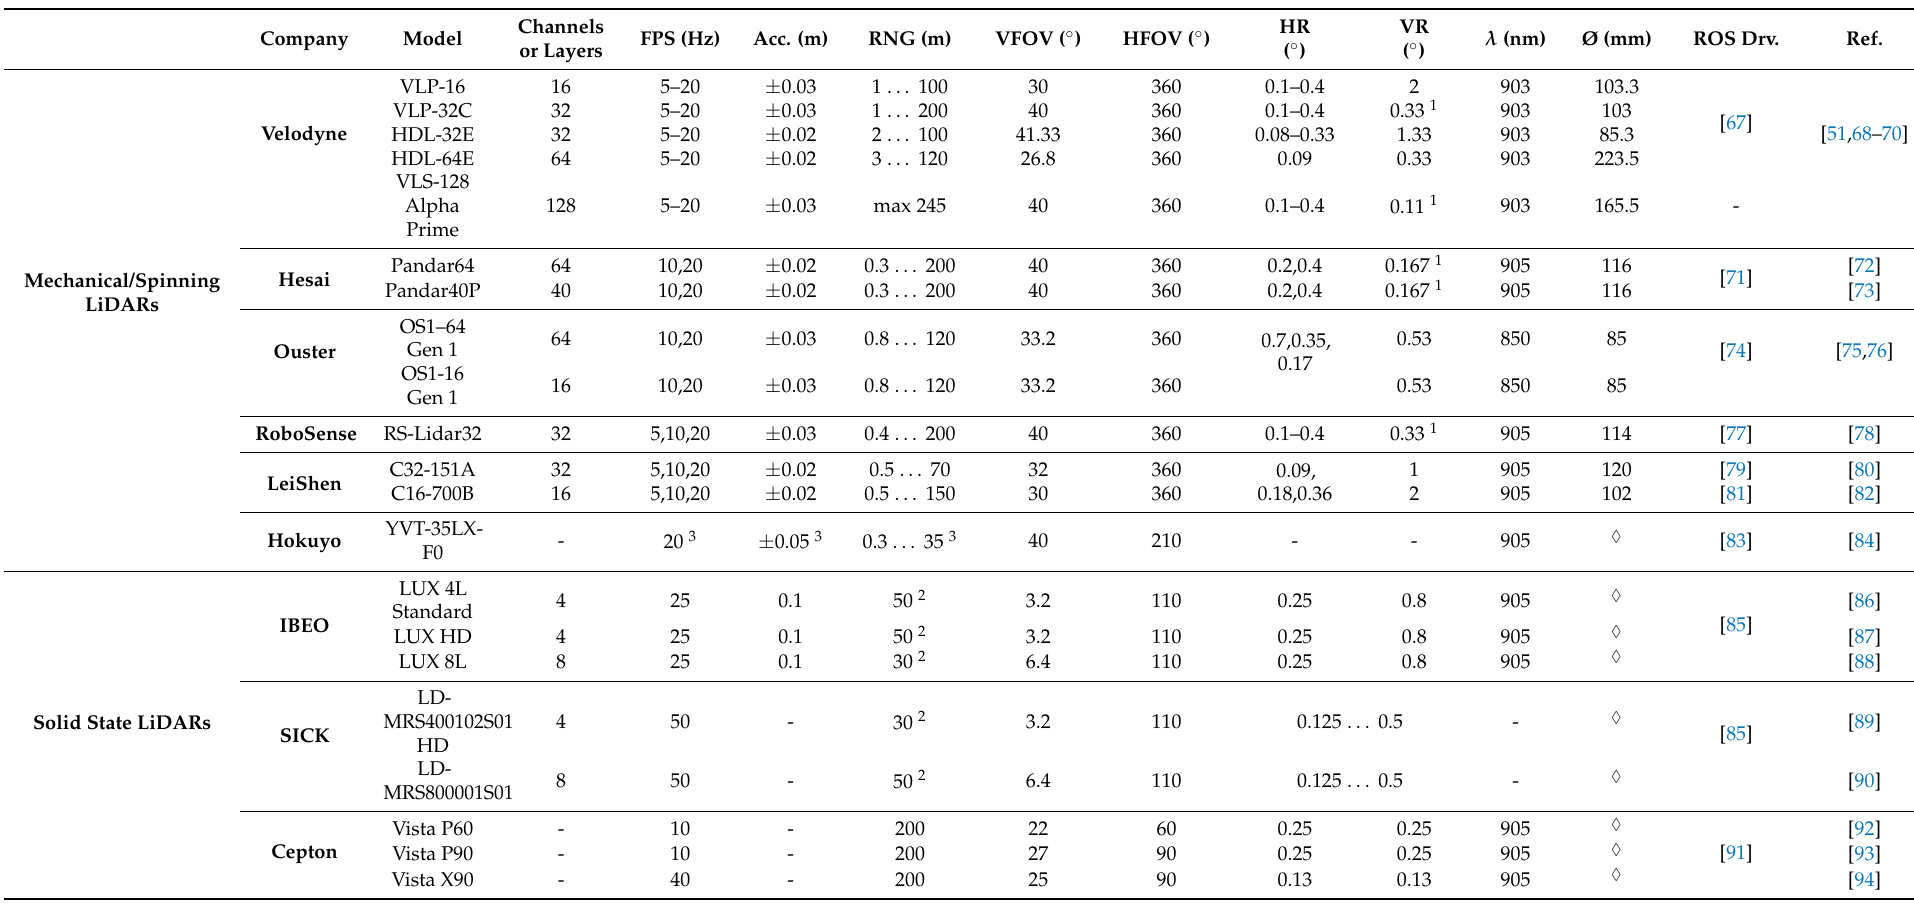
Table 3. General specifications of the tested LiDARs from [64,65] and other LiDARs that were reviewed in the current work. The acronyms from left to right (first row) are frames per second (FPS); accuracy (Acc.); detection range (RNG); vertical FoV (VFOV); horizontal FoV (HFOV); horizontal resolution (HR); vertical resolution (VR); wavelength ( λ ); diameter (Ø); sensor drivers for Robotic Operating System (ROS Drv.); and reference for further information (Ref.). The “-” symbol in table below indicates that the specifications were not mentioned in product